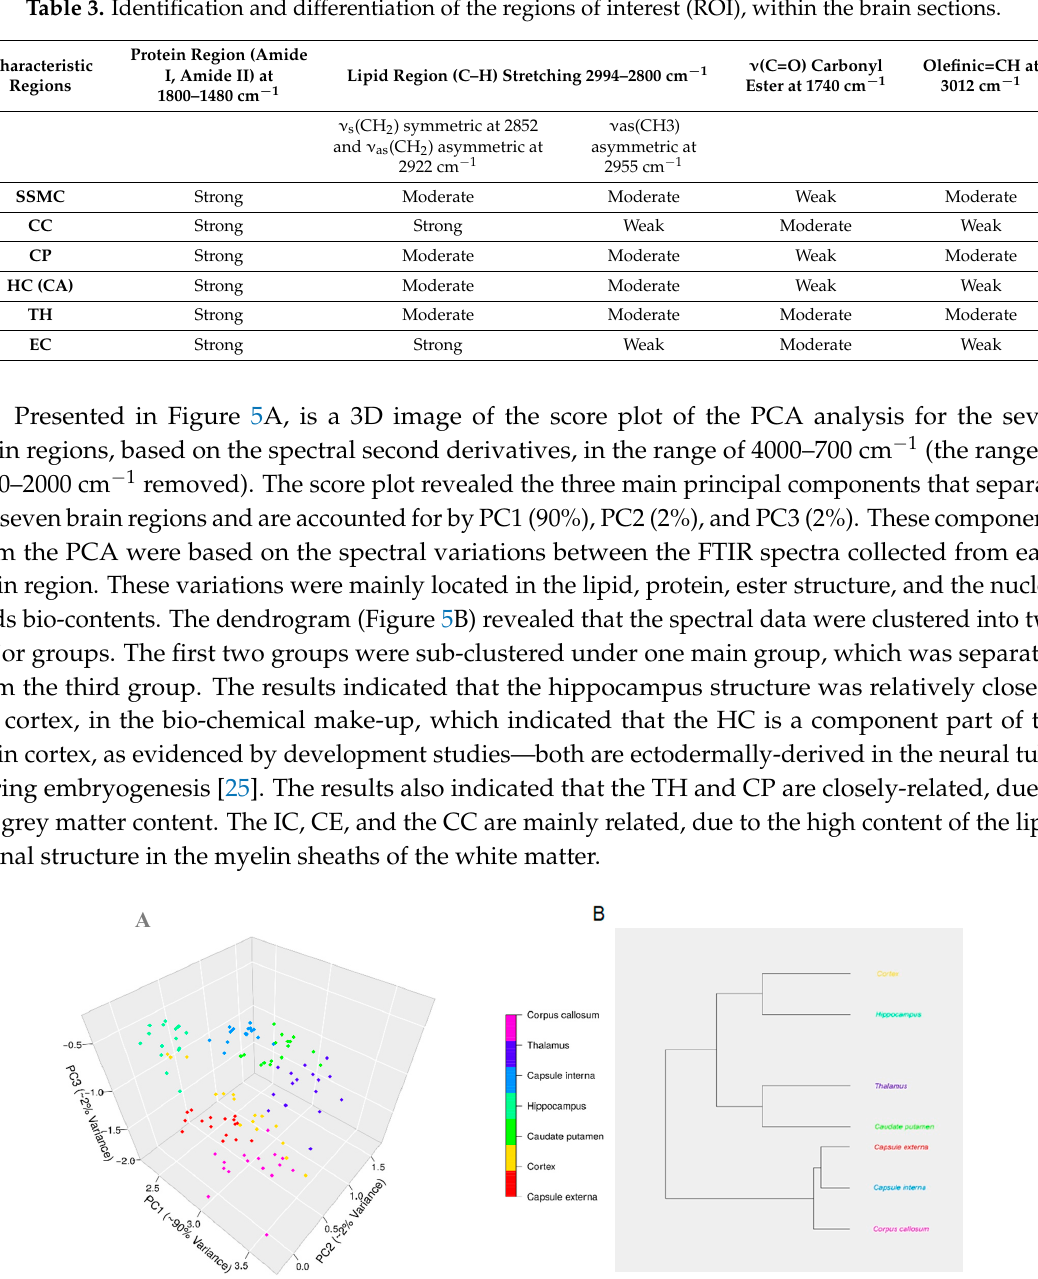
Figure 5. ( A ) PCA score plot for the seven brain regions. The three PCA values are given by PC1 (90%), PC2 (2%), and PC3 (2%). ( B ) Dendrogram representing the seven brain regions.